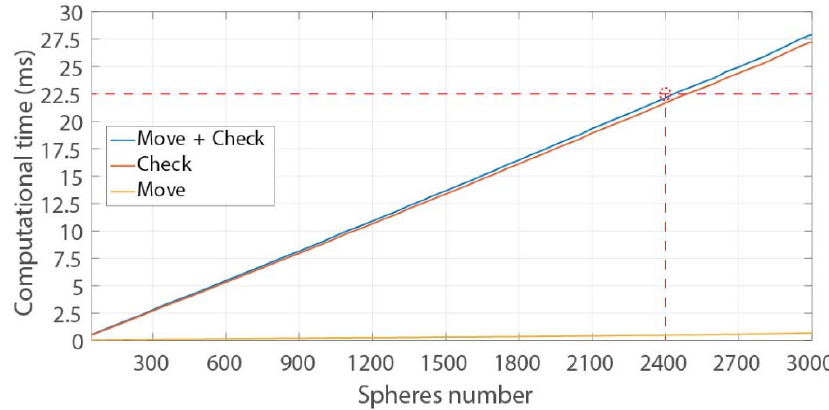
Figure 7. Computational time required to move the spheres and calculate the sphere distance to the manipulator. The dashed line corresponds to the imposed time constraint.